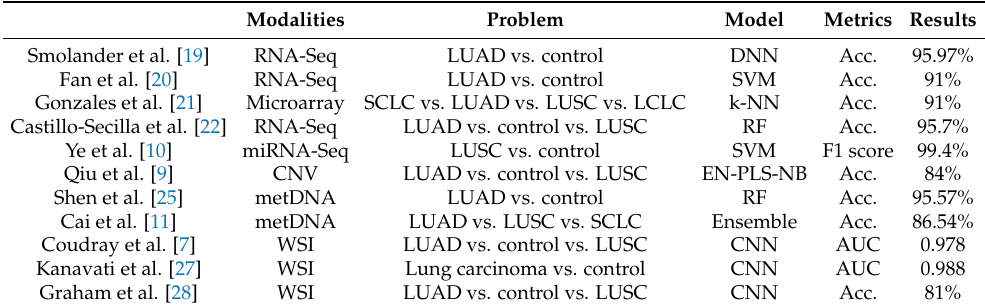
Table 1. Summary of works in the literature for different NSCLC classification problems. SVM: support vector machine; DNN: deep neural network; RF: random forest; CNN: convolutional neural network; k-NN: k-nearest neighbor; Acc.: accuracy; AUC: area under the curve.